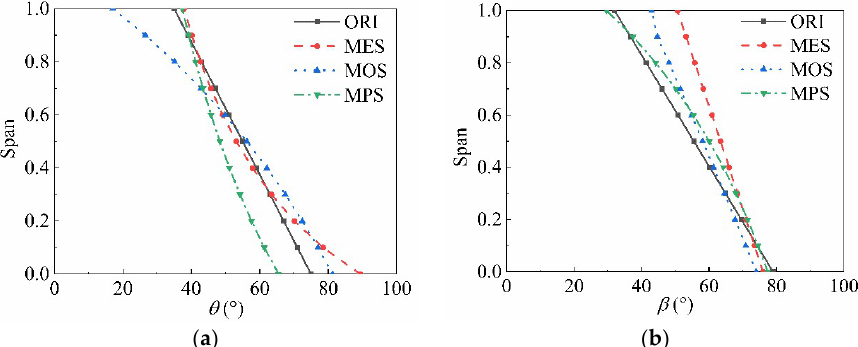
Figure 13. The distribution curves of θ and β along the spanwise direction: ( a ) the radial distribu- tion of θ ; ( b ) the radial distribution of β .